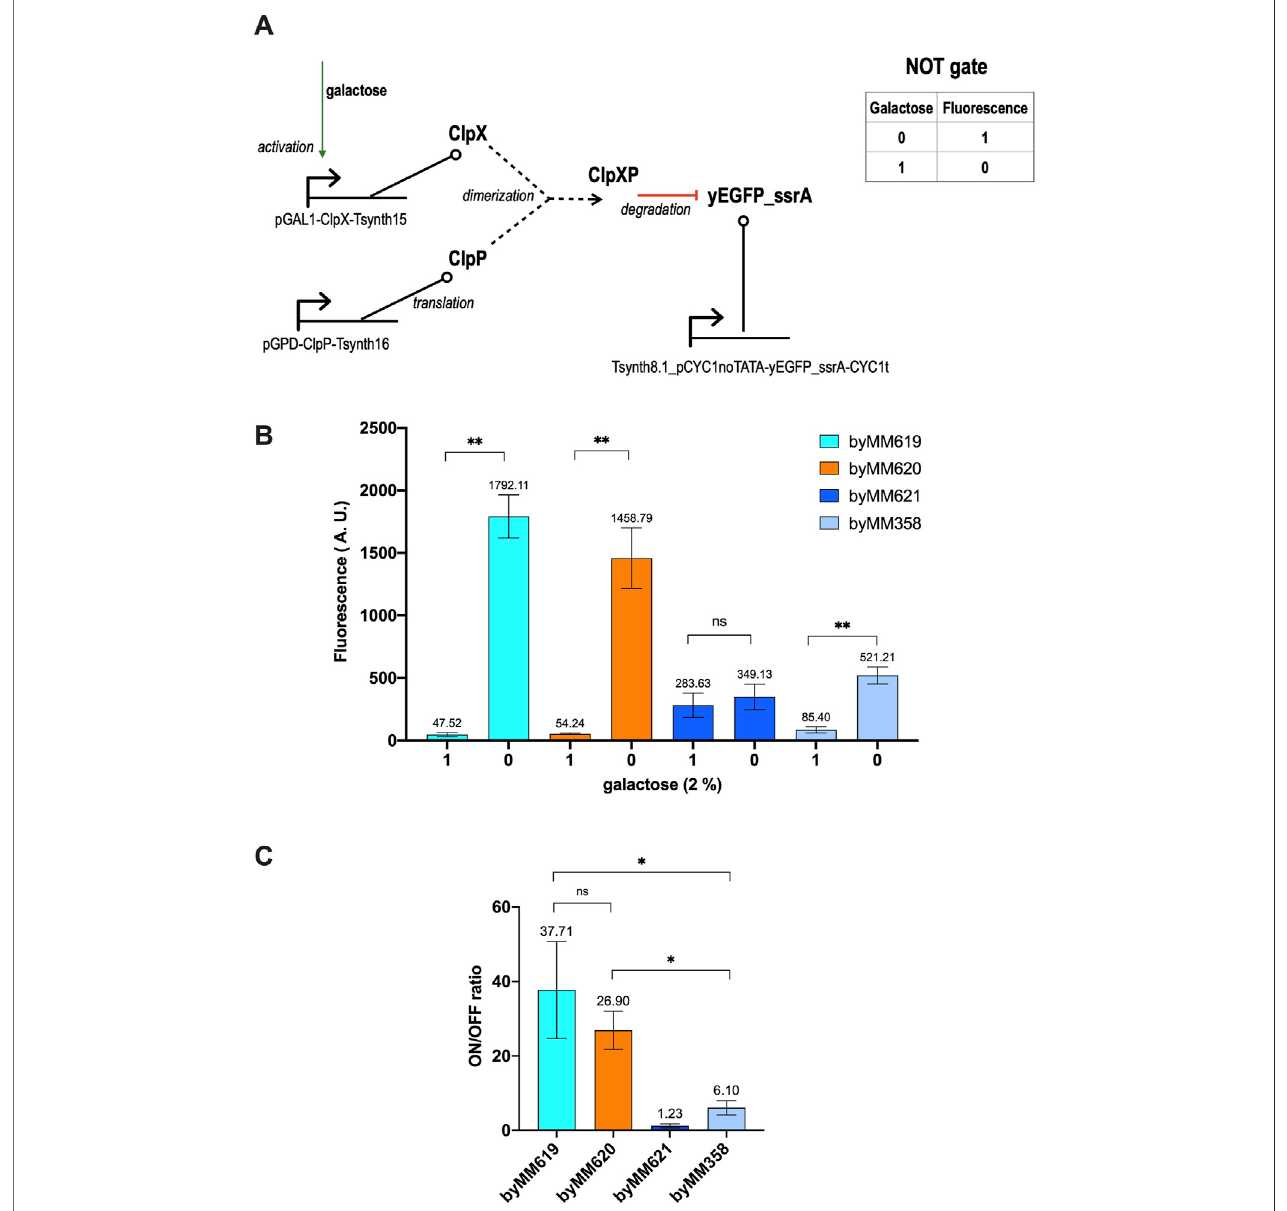
FIGURE 1 | Galactose-sensing NOT gate. (A) Circuit scheme. The reporter protein (yEGFP_ssrA) and ClpP are constitutively expressed by the rather weak syntheticpromoterTsynth8.1_pCYC1noTATAandthestrongyeast GPD promoter,respectively.ClpX(ayeastcodonoptimizedversion)synthesisisswitchedONonlyin the presence of galactose. Differently from the network in (Grilly et al., 2007), only the expression of one of the two components of the ClpXP dimer is controlled by an input. Moreover, the production of the tagged green fl uorescent protein cannot be stopped by any external signal (see Supplementary Figure S1 for a comparison). (B) Average fl uorescence level (together with its standard deviation)corresponding to four strains hosting aNOT gate. byMM619 and byMM620 show the highest separation between the 0 and 1 output level. byMM621, in contrast, turned out to be unfunctional. byMM358 differs from the previous three gates for the synthetic promoter DEG1t_pCYC1noTATA that expresses yEGFP_ssrA instead of Tsynth8.1_pCYC1noTATA. DEG1t_pCYC1noTATA is 1.37-fold stronger than Tsynth8.1_pCYC1noTATA. (C) Gate performance in term of fl uorescence gain. byMM619 and byMM620 turned out not to be signi fi cantly different under